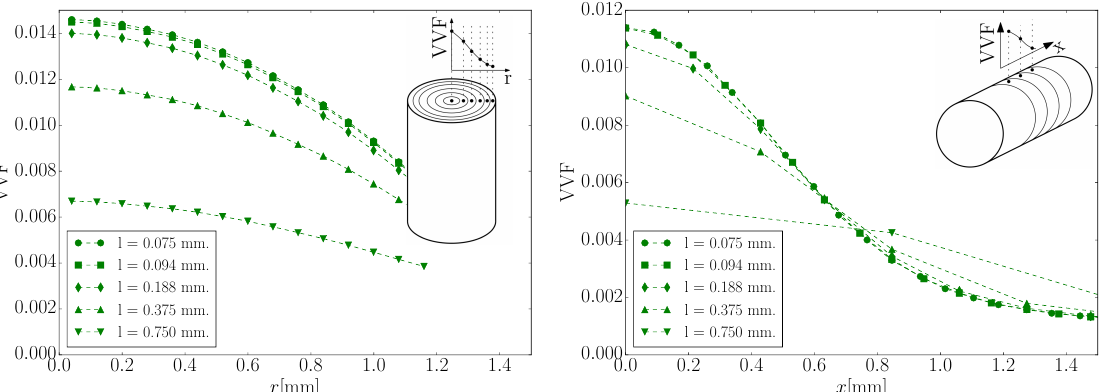
Figure 18. Radial ( left ) and longitudinal ( right ) voids distribution of a specimen of Material 1 at step 4 obtained using meshes with different element longitudinal lengths.